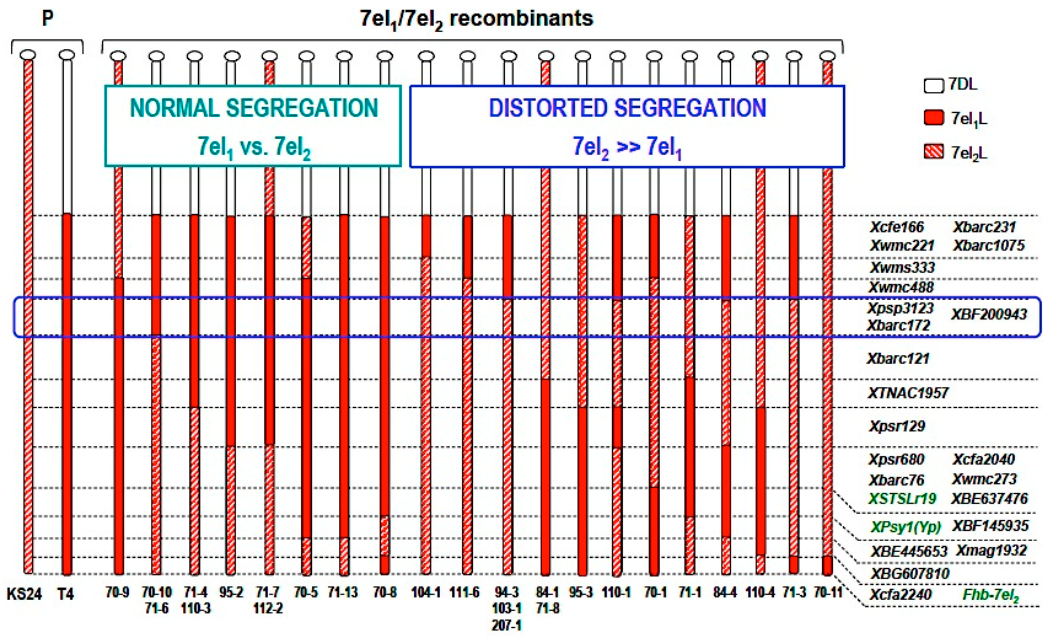
Figure 5. Cytogenetic maps of the 7DL-7el 1 L/7el 2 L arms of bread wheat– Th. ponticum recombinant chromosomes, isolated from KS24-1/T4/cv. Blasco crosses, based on molecular marker analysis and genomic in situ hybridisation (GISH). Dotted lines indicate the 7DL/7el 1 L/7el 2 L breakpoints. The location of the 7el 2 L region that is likely to have the main effect on segregation distortion observed in this context (see text), is bounded by the violet box. P = parental lines. Modified from Forte et al., 2014 [41].